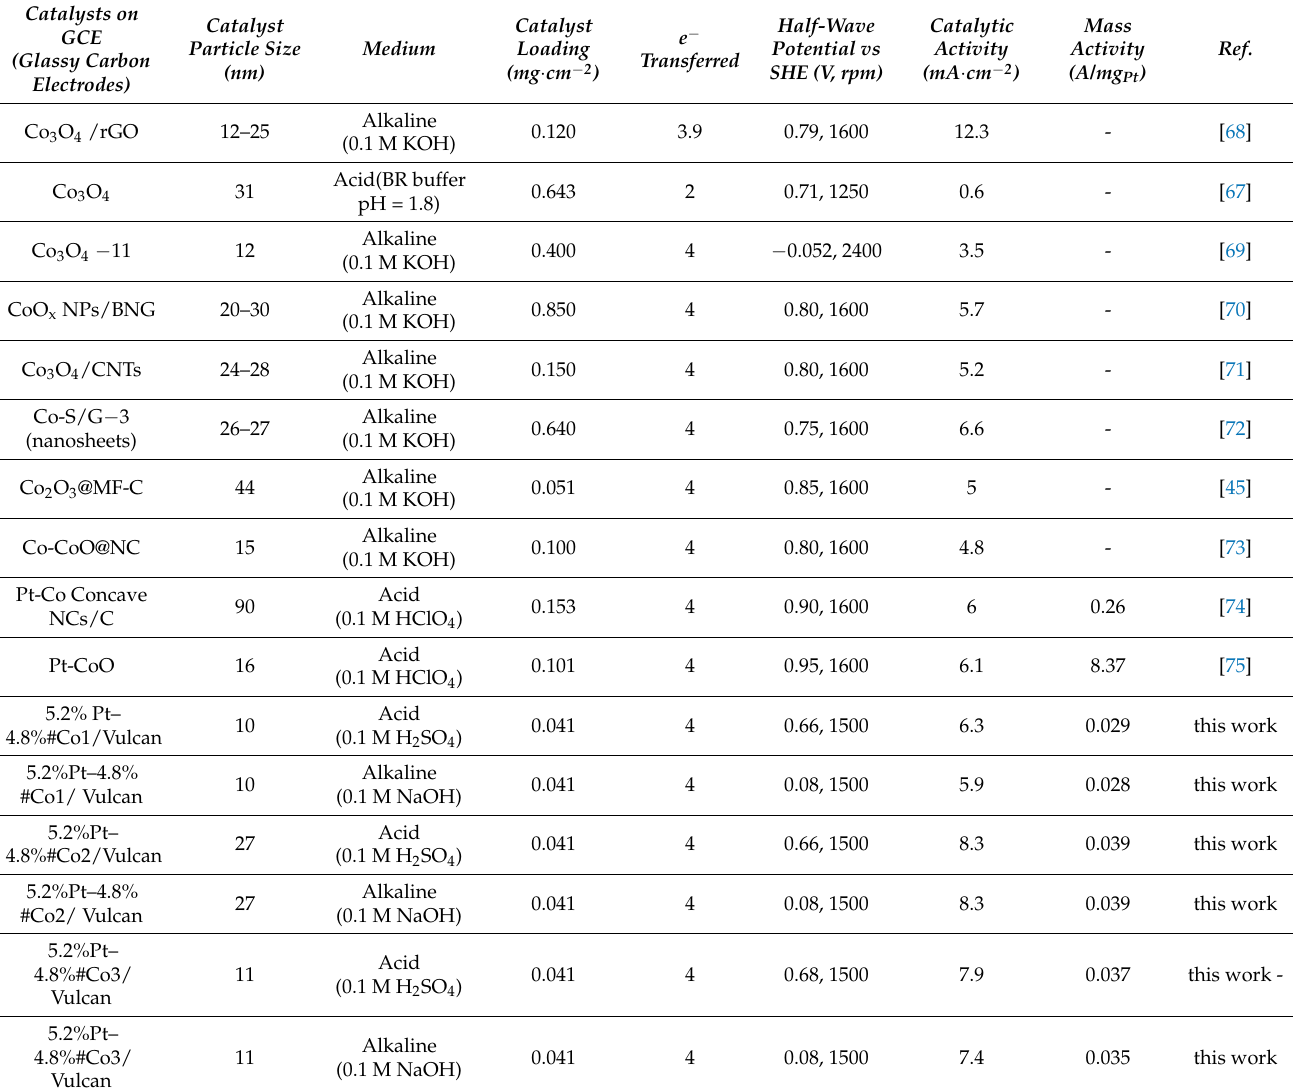
Table 2. Comparison of ORR performance of the present FSP-Nanocatalysts vs. literature data for Co-based catalysts. Catalysts on GCE (Glassy Carbon